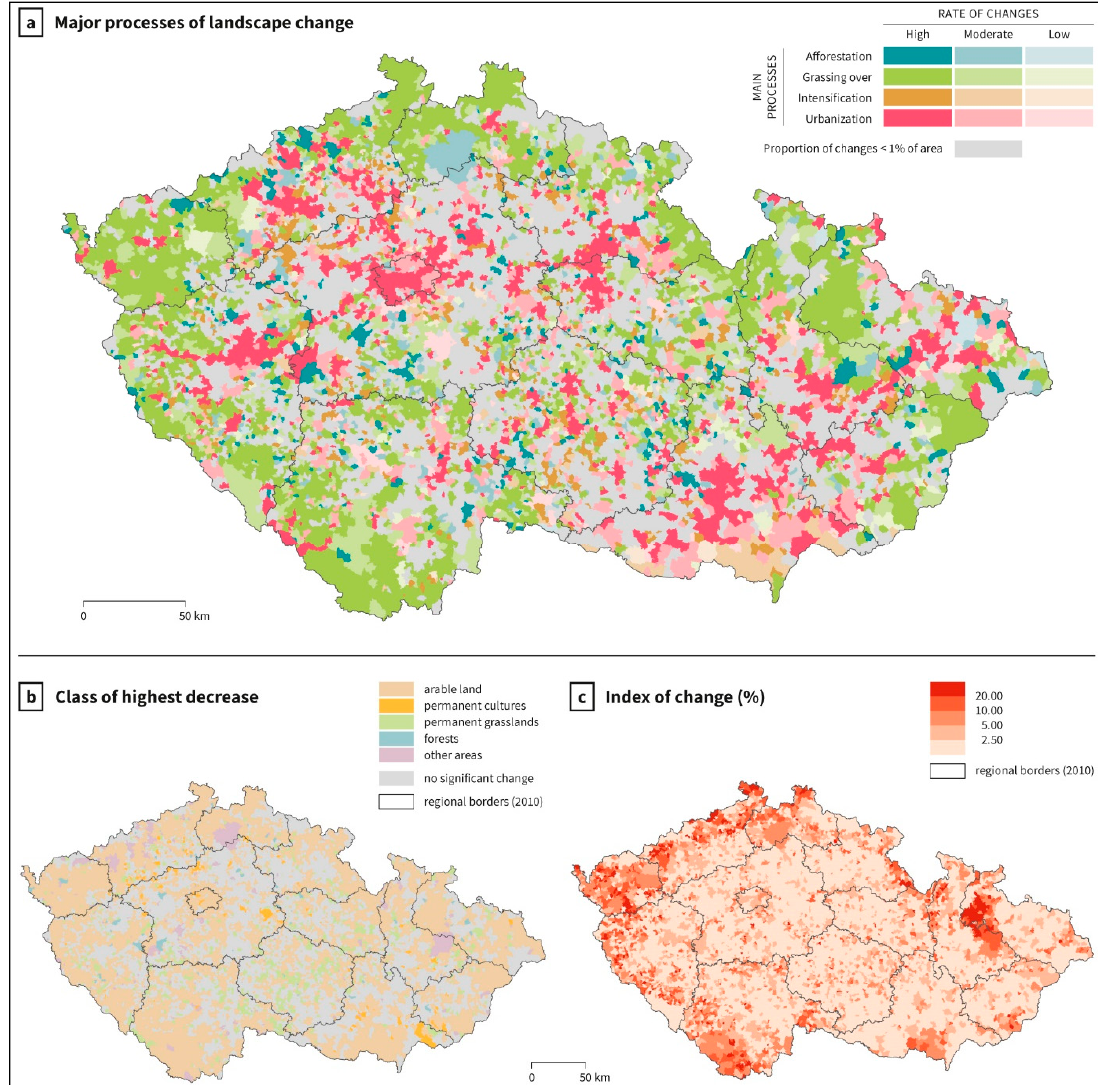
Figure 5. Major processes and intensity of landscape change between 1990 and 2010. The transition of arable land into meadows and pastures was typical in regions with less favorable natural conditions (supported by subsidies from the EU Common Agricul- tural Policy and other schemes of both the European Union and the state focused on sus- tainable landscape management) and constituted the major process of landscape change in STUs covering 33.8% of the national territory (Figure 5a and Table 2). The abovemen- tioned property restitution, in addition to the changing nature of agricultural subsidies, played a major role in this process; subsidies were more intended to secure “landscape maintenance” rather than production per se. The expansion of forests was also important. The intensity of landscape change differed significantly among regions. The most in- tensive changes (Figure 5c) were recorded in areas where agriculture declined, and fields were transformed into meadows and pastures (typically in mountainous regions flanking the border). Regions that were subject to strong suburbanization (i.e., around cities and along major highways) also showed higher intensity of change (changes were recorded in many cases on more than 20% of total area of STU). Suburban areas became attractive for people seeking better housing, and new residential projects were often built on arable land.